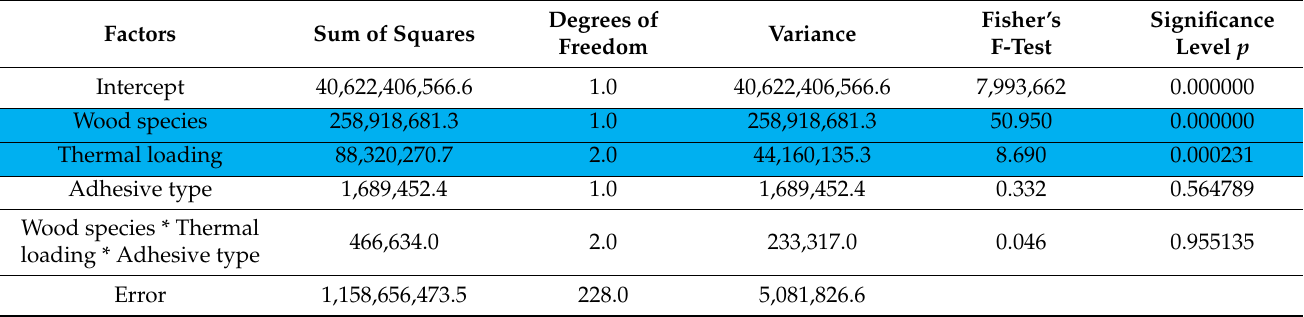
Table 4. Statistical evaluation of modulus of elasticity E m